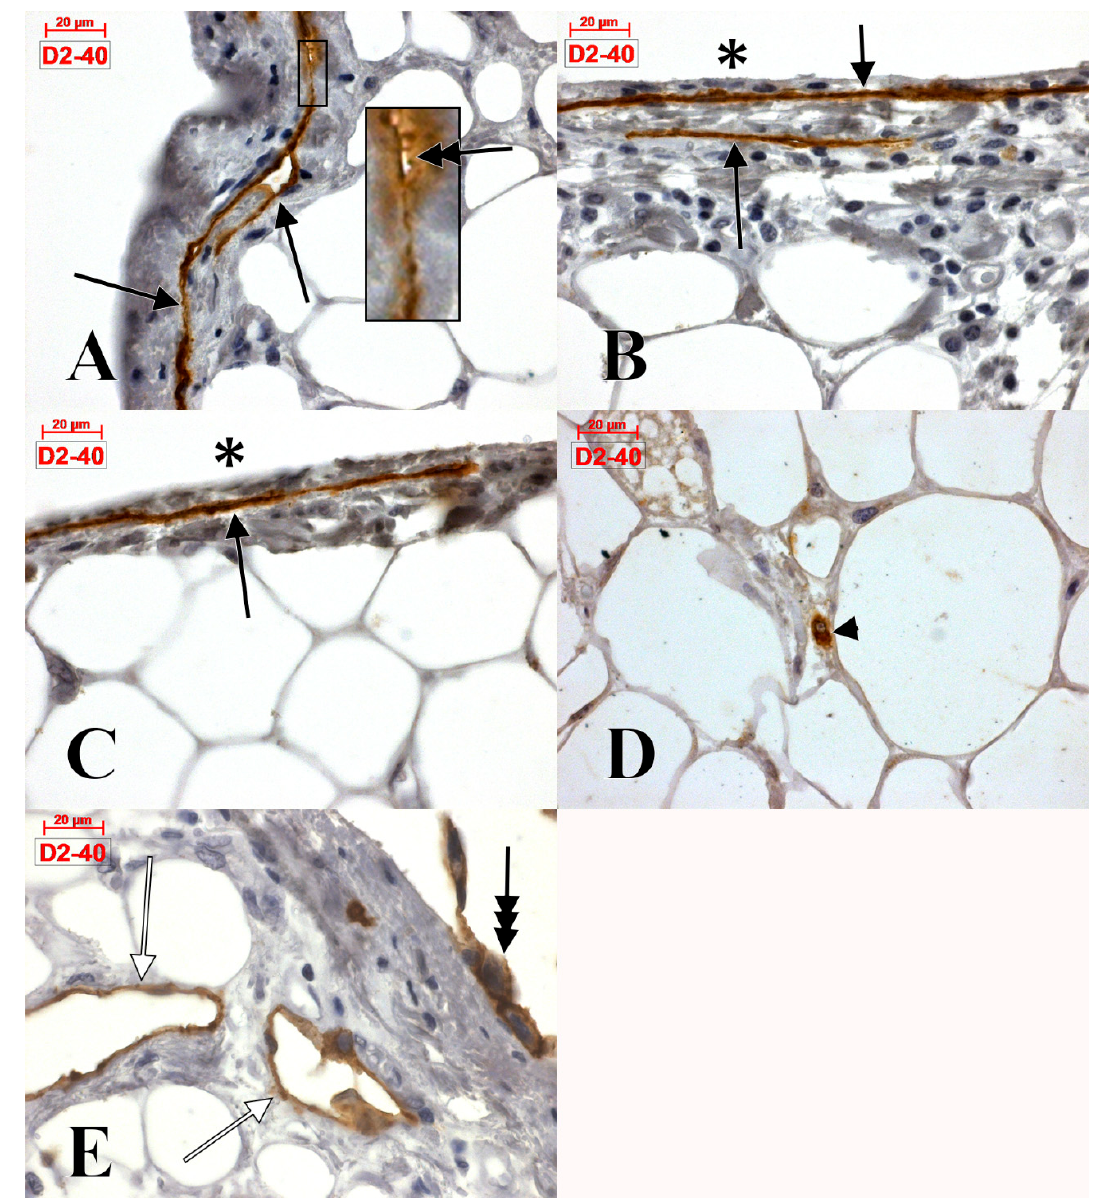
Figure 1. Human adult cardiac wall ( A – D : left atrial wall, E : left atrial appendage). Epicardial and subepicardial expression of podoplanin (D2-40). Thin subepicardial lymphatics express D2-40 ( A – C , arrows). When they are tangentially cut, they could be confused with telopodes ( A , inset, digitally magnified) if the narrow lumen (double-headed arrow) is overlooked. The arrowhead in ( D ) indicates a D2-40-expressing isolated cell embedded within the subepicardial fat. Although epicardium was largely denuded of epithelium (*) in the studied samples, there were found areas covered by D2-40 + hypertrophied mesothelial cells (E, triple-headed arrow). Large lymph collectors with intraluminally bulged endothelial cells were found embedded within the subepicardial fat (E, white arrows).